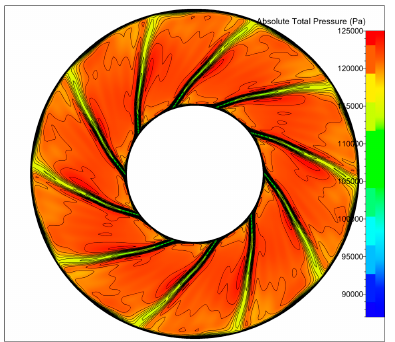
Figure 40. Instantaneous field of total pressure, section at the first rotor outlet. Operating point at the nominal rotational speed. n = 100%.